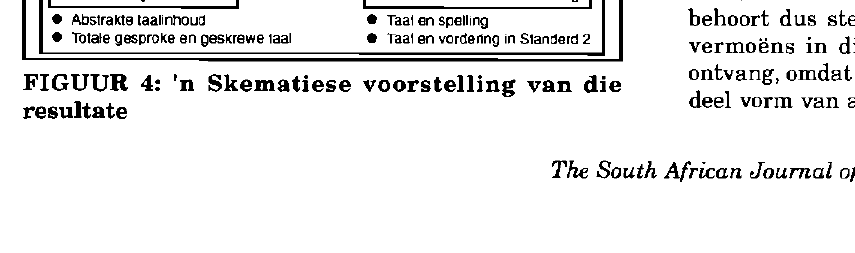
FIGUUR 4: 'n Skematiese voorstelling van die